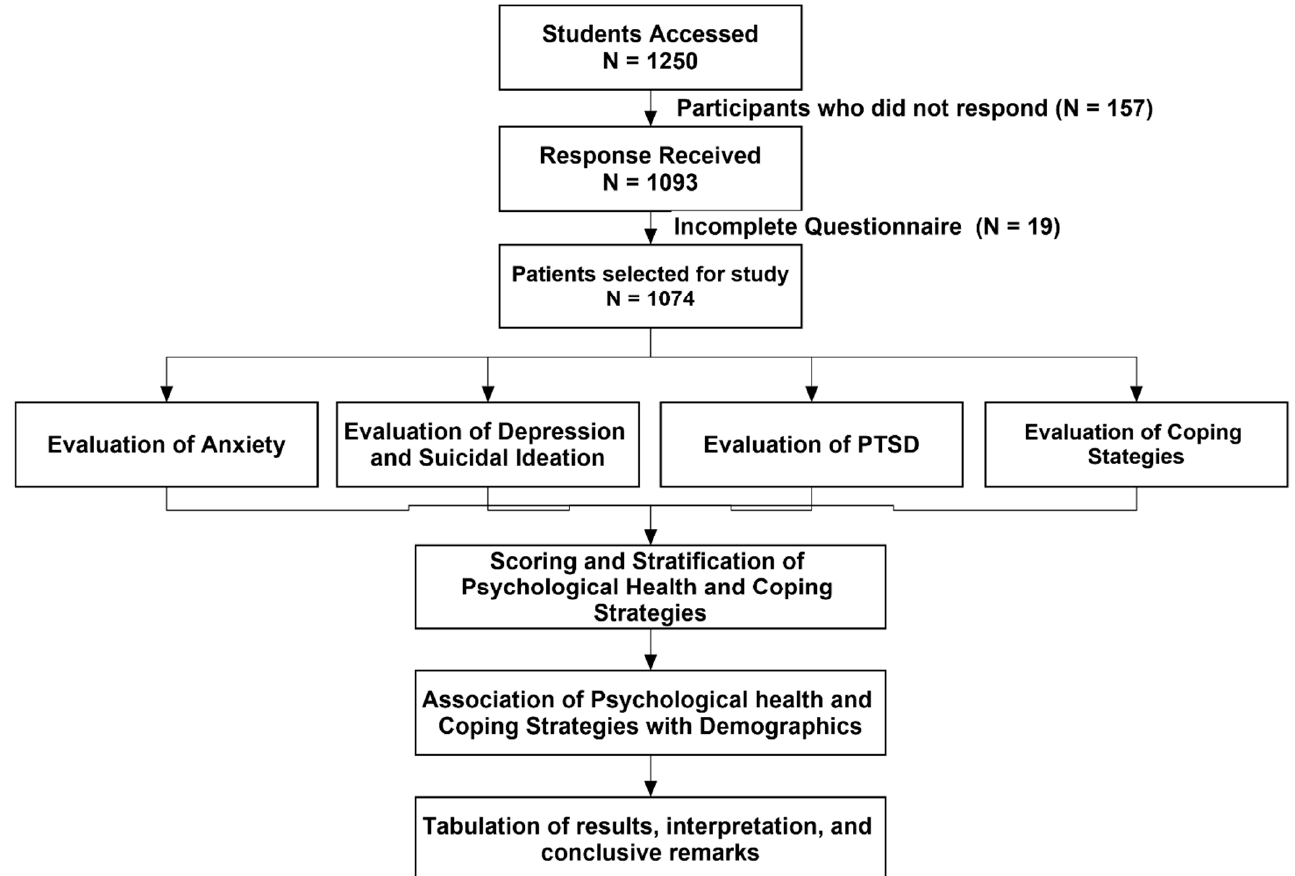
Figure 1. Study flow diagram.